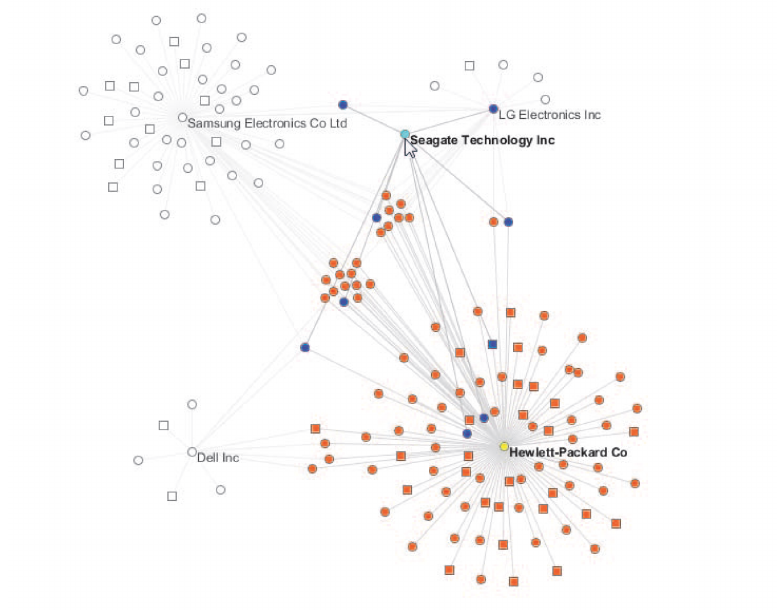
Figure 16. The Path view in the connectivity perspective of the software. Clusters of companies can be seen as market segments where the links between nodes signify the company agreements. Image courtesy of Basole et al.